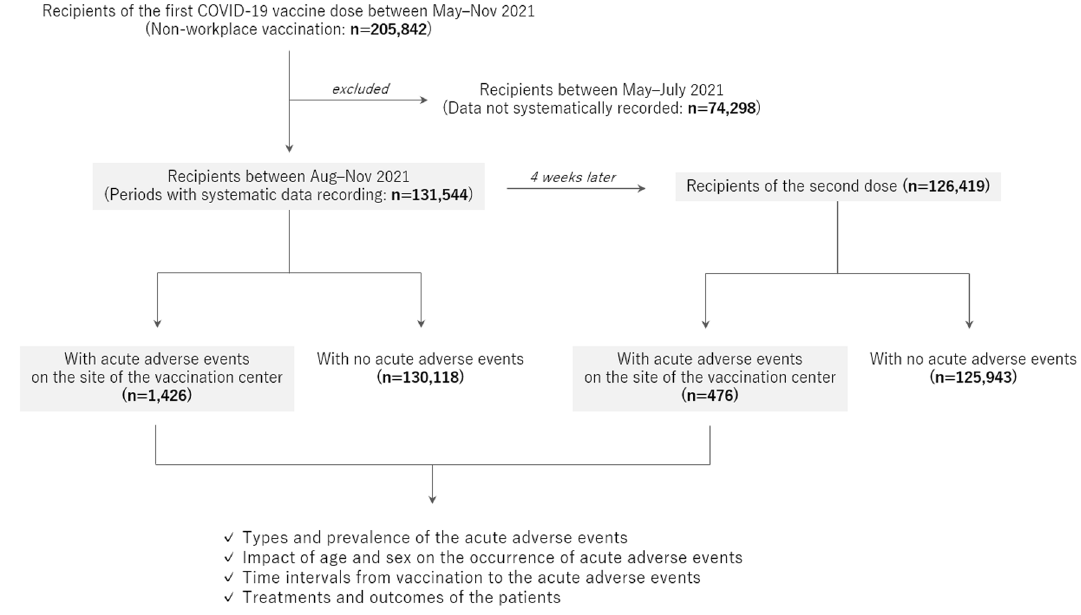
Figure 1. Flow diagram of the study design. All recipients of the Moderna mRNA vaccine against COVID- 19 at a single mass vaccination center were enrolled in the study. Detailed information on the occurrence